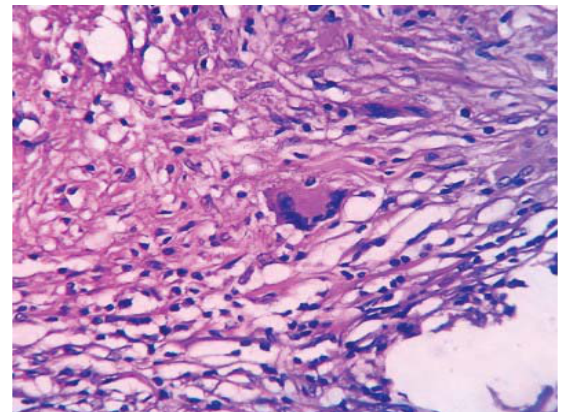
Figure 2. H&E stained section showing Langhans (cid:80)(cid:88)(cid:79)(cid:87)(cid:76)(cid:81)(cid:88)(cid:70)(cid:79)(cid:72)(cid:68)(cid:87)(cid:72)(cid:71)(cid:3)(cid:74)(cid:76)(cid:68)(cid:81)(cid:87)(cid:3)(cid:70)(cid:72)(cid:79)(cid:79)(cid:86)(cid:3)(cid:11)(cid:23)(cid:19)(cid:59)(cid:3)(cid:80)(cid:68)(cid:74)(cid:81)(cid:76)(cid:191)(cid:70)(cid:68)(cid:87)(cid:76)(cid:82)(cid:81)(cid:12) Breast tuberculosis is extremely rare in males, with the (cid:191)(cid:85)(cid:86)(cid:87)(cid:3) (cid:70)(cid:68)(cid:86)(cid:72)(cid:3) (cid:69)(cid:72)(cid:76)(cid:81)(cid:74)(cid:3) (cid:85)(cid:72)(cid:83)(cid:82)(cid:85)(cid:87)(cid:72)(cid:71)(cid:3) (cid:76)(cid:81)(cid:3) (cid:20)(cid:28)(cid:21)(cid:26)(cid:17) 7 Few case reports on male breast tuberculosis reveal that the presentation is of a unilateral breast mass with or without ulceration along with axillary lymphadenopathy.